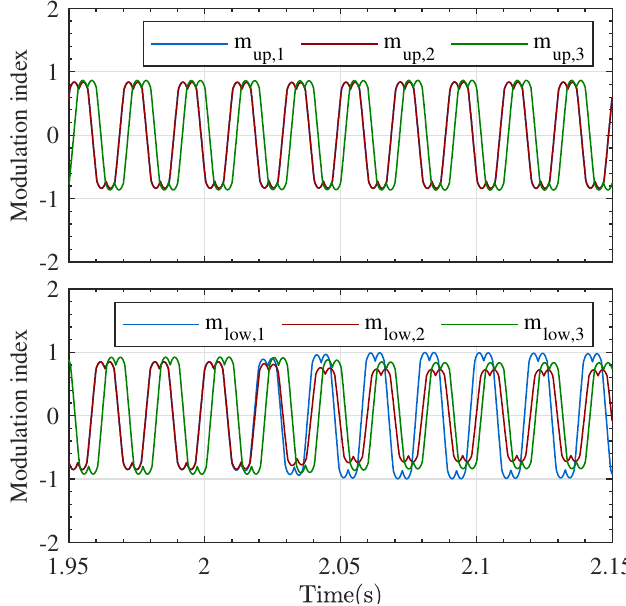
Figure 11. Modulation index in the modules of the upper and lower arms after the third